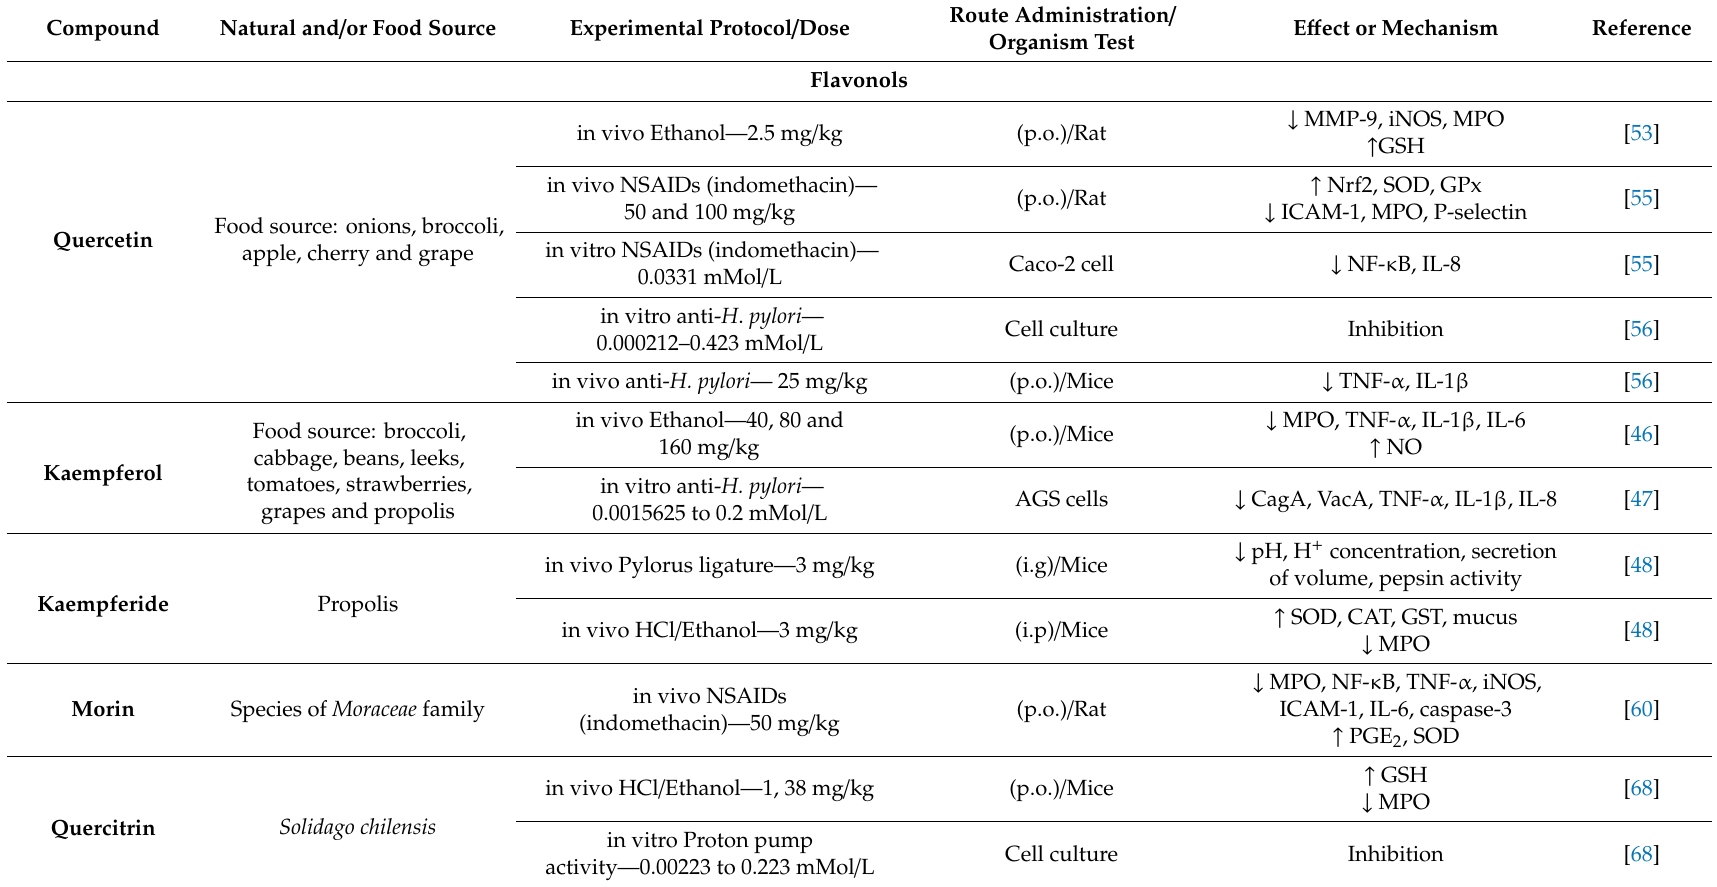
Table 1. Flavonoids with gastroprotective and / or anti-ulcer